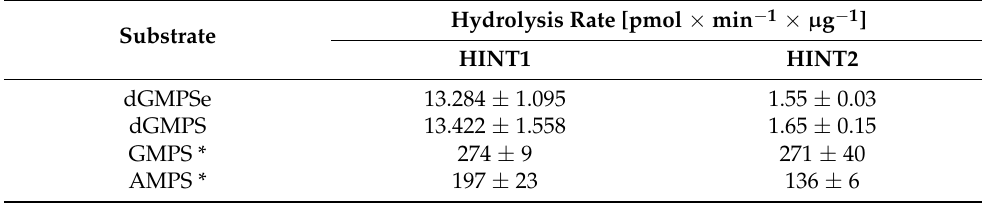
(Table 1). Similar hydrolysis rates (about 13 pmol × min − 1 × µ g − 1 ) were observed for both 2 (cid:48) -deoxy series substrates (dGMPSe and dGMPS), while GMPS was a significantly better substrate (by one order of magnitude). Table 1. Hydrolysis rate of dGMPSe and its thio-analogs (dGMPS and GMPS) catalyzed by HINT1 or HINT2. The substrates were tested at a concentration of 50 µ M. Results in pmol × min − 1 × µ g − 1 are given as means ± SEM of experiments performed at least in